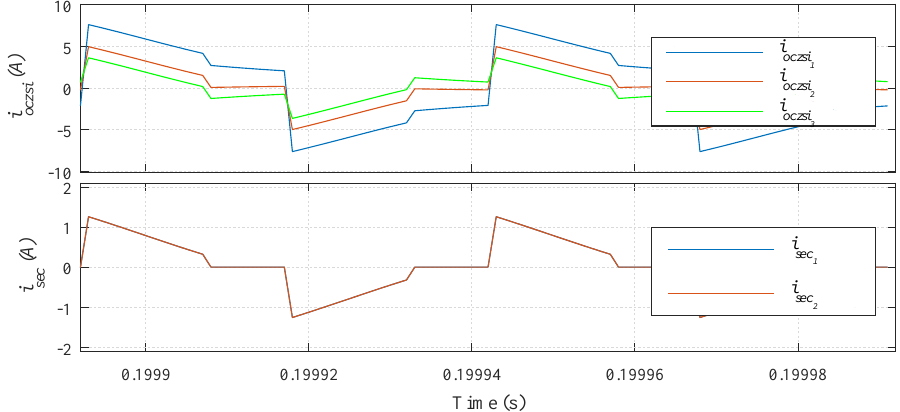
, i oczsi , i oczsi and secondary ports 2 3 1